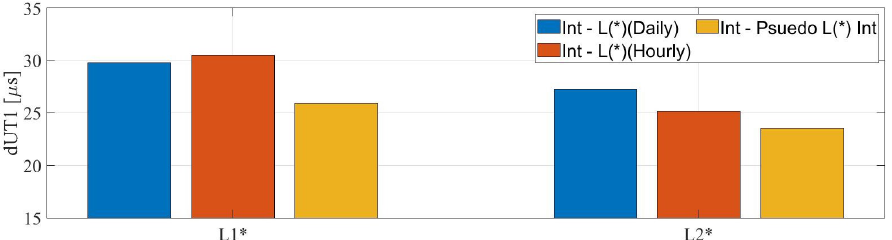
Figure 10. The root mean square values of the differences between daily and hourly dUT1 from the IVS-Int and the 24 h sessions (L1 and L2), represented by blue and red color; the RMS of the differences between dUT1 from IVS-Int and the pseudo Intensive sessions, represented by yellow color.